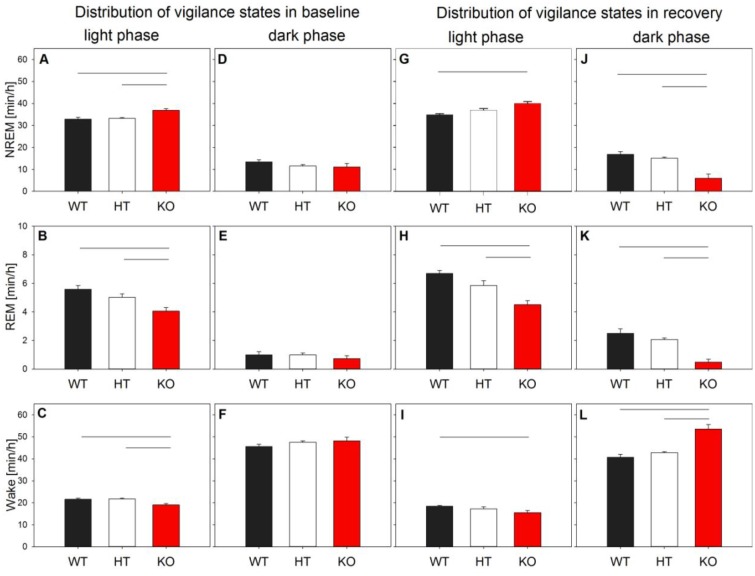
Duration of vigilance states in Grm5 KO, HT and WT mice at baseline and recovery light and dark phases.Mean amounts of NREM sleep, REM sleep and wakefulness over the 12 hr light and 12 hr dark phase of baseline mean (left panel, A–F) and the 6 hr light and 12 hr dark phase of recovery (right panel, G–L). During the baseline light period, KO mice show slightly more NREM sleep and slightly less REM sleep and wakefulness than their littermates (A–C). No significant differences in the dark phase were observed (D-E). During the light phase of recovery, KO mice show slightly more NREM sleep and slightly less REM sleep and wakefulness than their WT littermates (G–I). In the dark phase, KO spent less time in NREM and REM sleep than their littermates and more time in wakefulness (J–L). Statistics represent Holm corrected t-tests (lines), following significant ‘genotype x hour’ interactions or ‘genotype’ effect in overall two-way ANOVAs (pall <0.03 for WT vs. KO and HT vs. KO). Data represent means + SEM in n = 8 mice/genotype.